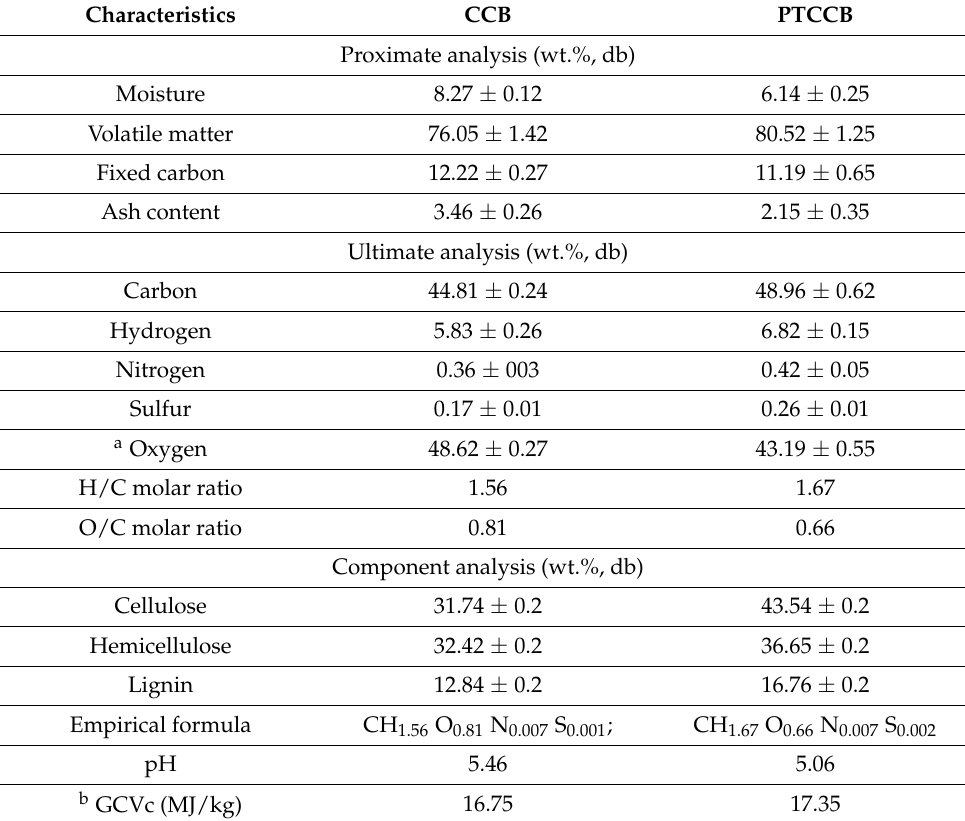
Table 2. Proximate, ultimate, and component analysis of CCB and PTCCB samples.